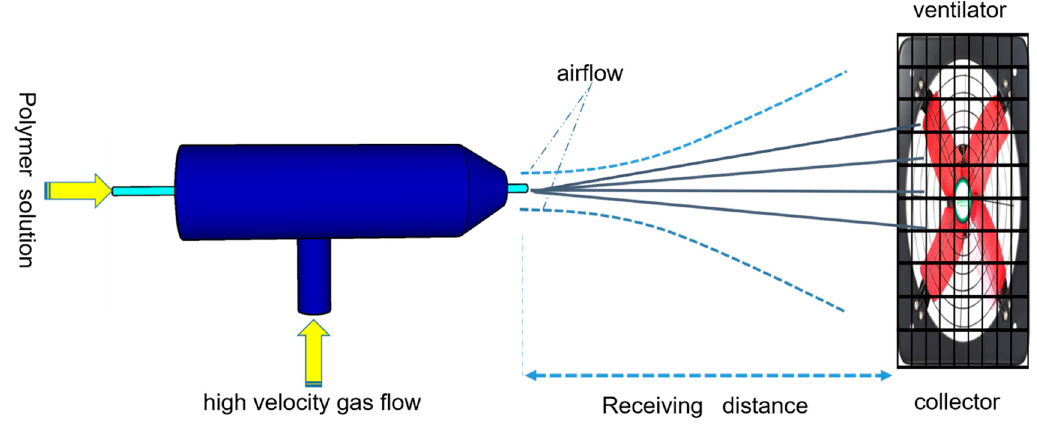
Figure 1. The preparation process of PVDF nonwoven membrane via solution blow spinning.